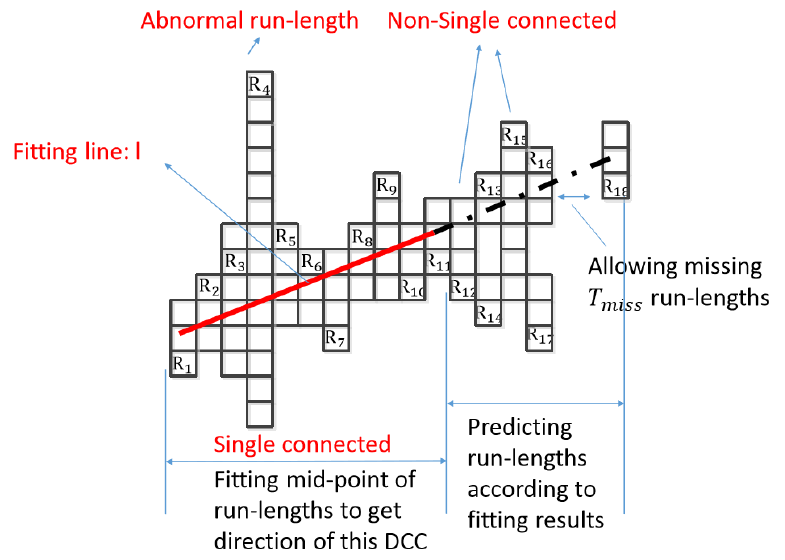
Figure 4. Searching a horizontal